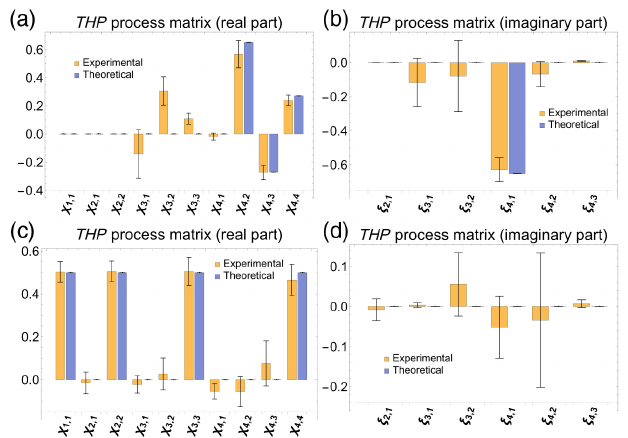
FIG. 14. Tomographic reconstruction of THP unitary operator. From top left to bottom right: (a),(b) real and imaginary parts of process matrix, given correct decryption, and (c),(d) real and imaginary parts of process matrix, given wrong